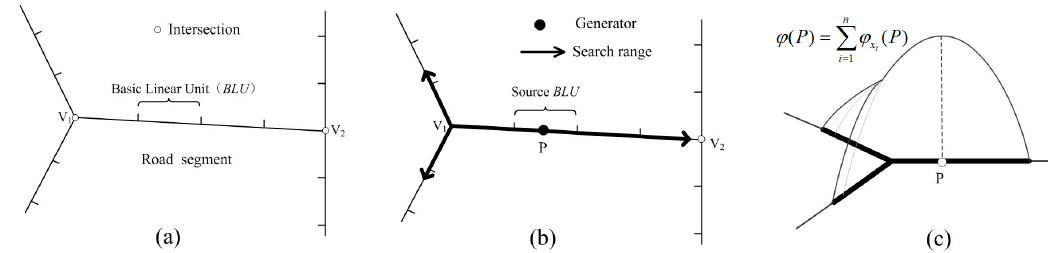
Figure 5. Algorithm implementation for spatiotemporal clustering of network events based on data field. ( a ) Road segments subdivision, ( b ) point features processing and ( c ) spatiotemporal